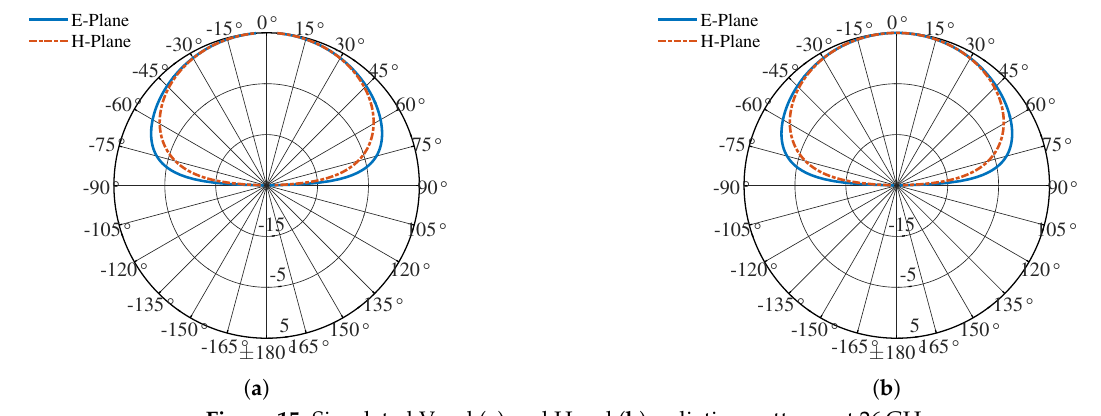
Figure 15. Simulated V-pol ( a ) and H-pol ( b ) radiation patterns at 26GHz.